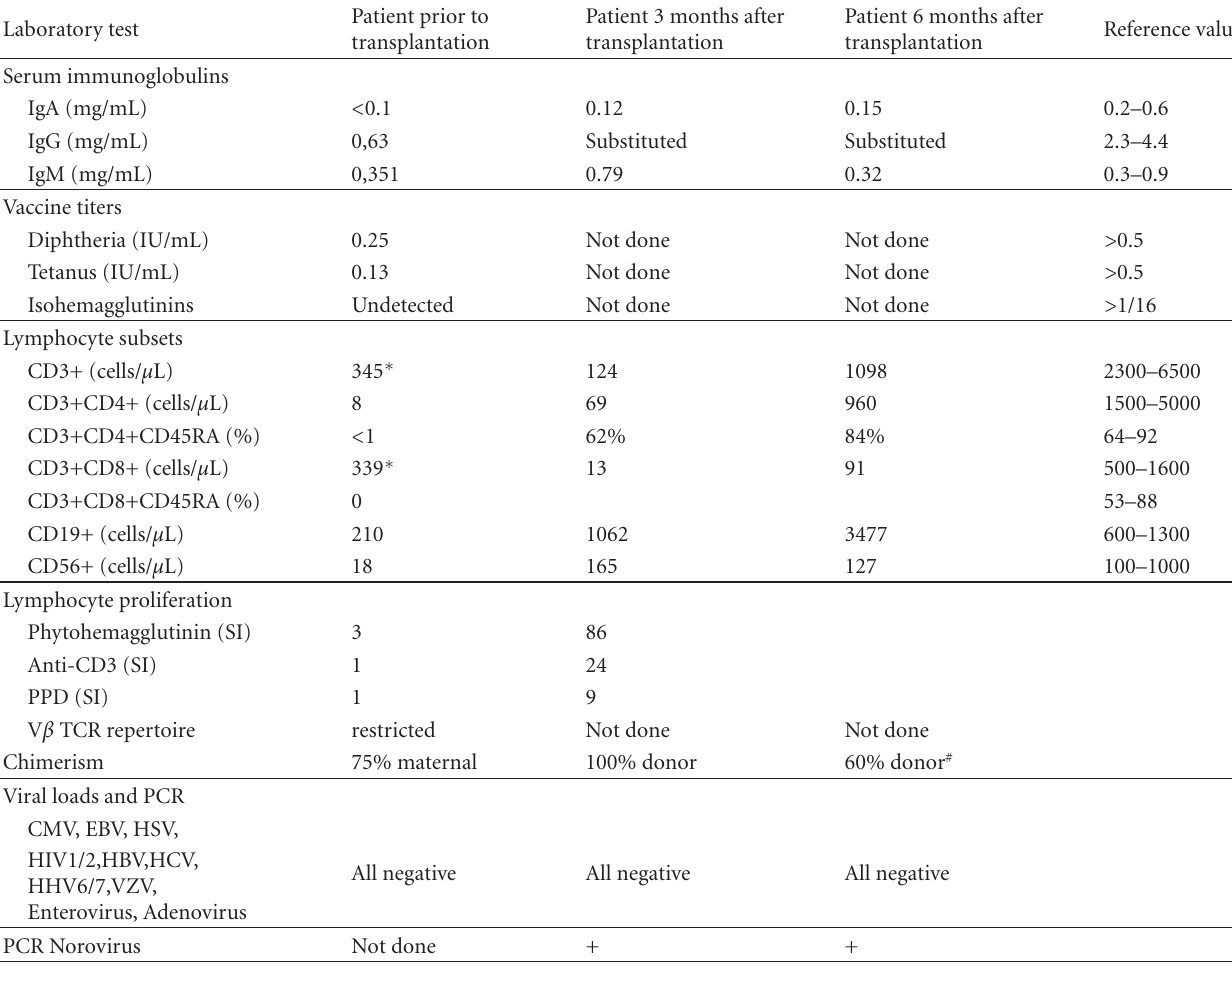
Table 1: Laboratory results. ∗ Maternal T cells in chimerism analysis. # Total chimerism 60% donor, 40% patient. Myeloid chimerism 100% patient, T and NK cell chimerism 100% donor.